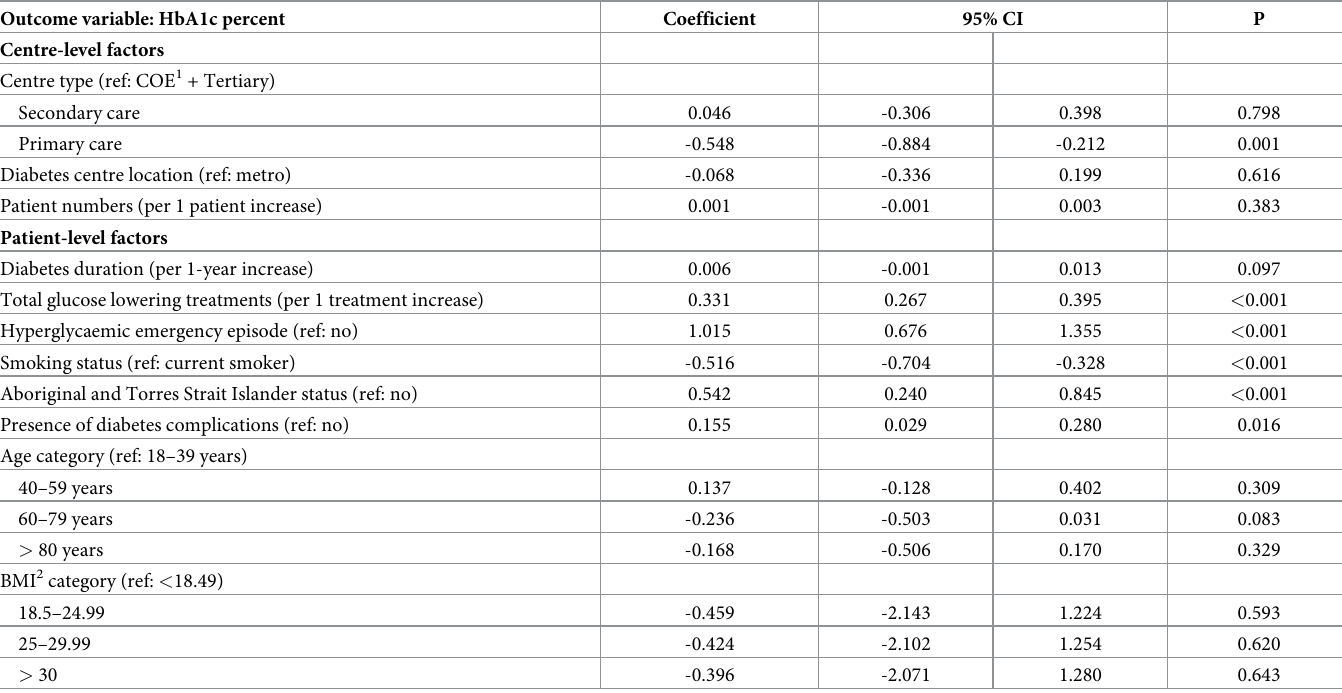
Table 4. Mixed effects multivariate modelling of HbA1c variation, type 2 diabetes.